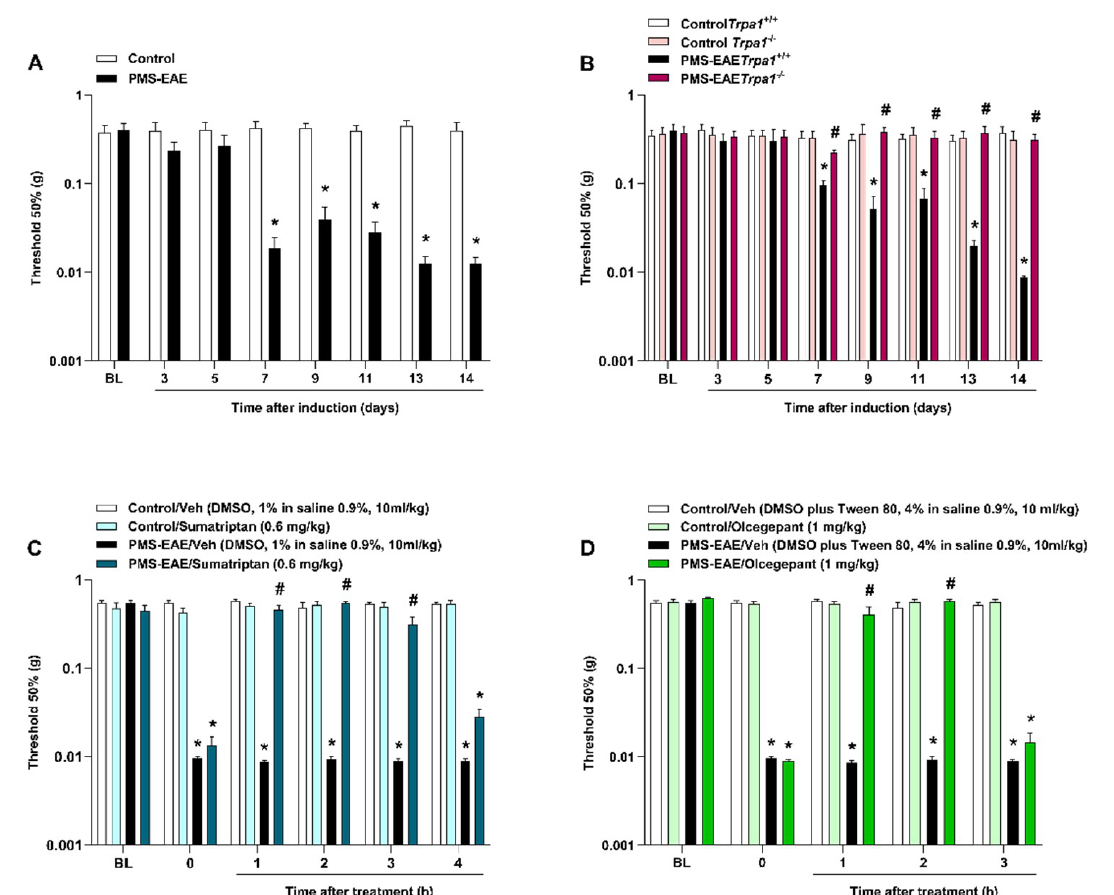
Figure 1. Progressive multiple sclerosis model by experimental autoimmune encephalomyelitis (PMS-EAE) caused PMA development, but Trpa1 − / − mice induced to PMS-EAE did not develop PMA and antimigraine agents’ treatment reduced periorbital nociception. ( A ) Development of PMA 7 to 14 days after induction of PMS-EAE. ( B ) Absence of PMA in TRPA1 knockout mice after PMS-EAE induction when compared to control ( Trpa1 +/+ ). Intragastric (i.g.) administration of ( C ) sumatriptan (0.6 mg/kg) and intraperitoneal (i.p.) injection of ( D ) olcegepant (1 mg/kg) 14 days post-induction (p.i.) reduced the PMA generated by the PMS-EAE model. The vehicle group received dimethyl sulfoxide-DMSO 1% in isotonic saline 0.9% i.g. (sumatriptan) or 4% DMSO plus 4% Tween 80 in isotonic saline 0.9% i.p. (olcegepant). Basal (BL) values were observed before PMS-EAE induction. Data are expressed as mean + SEM (n = 6–8) in the graphs. * p < 0.05, when compared to the control group or baseline values (Two-way ANOVA, followed by Bonferroni’s post hoc test); and # p < 0.05 when compared with PMS-EAE vehicle-treated group (Two-way ANOVA, followed by Bonferroni’s post hoc